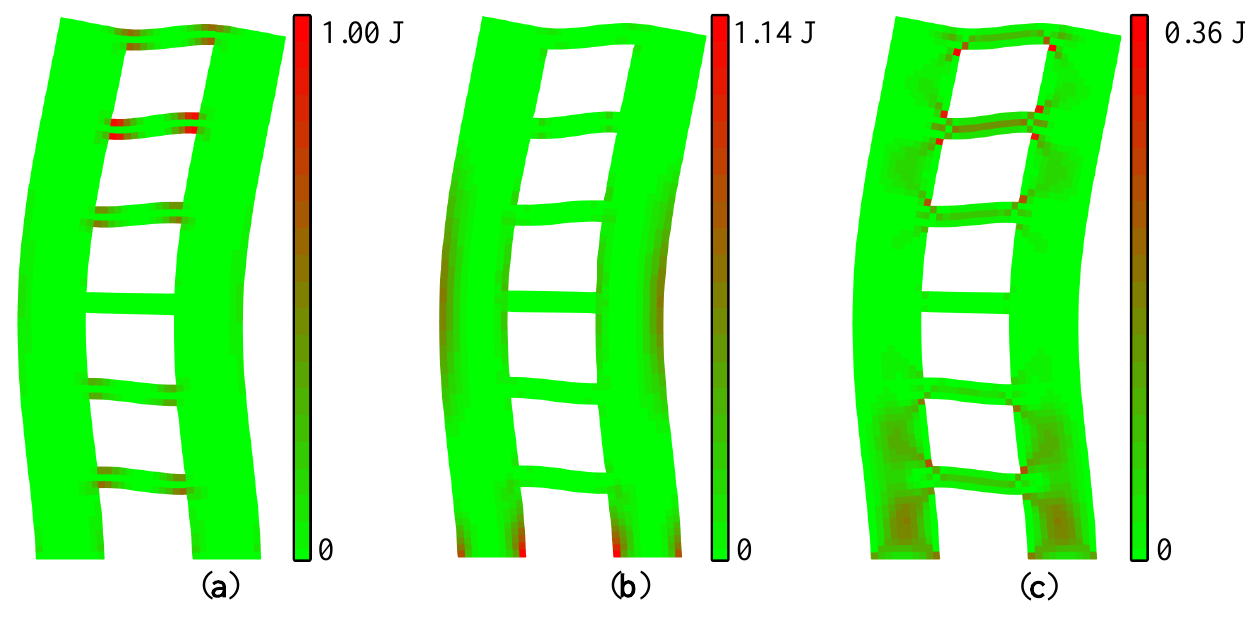
Figure 13. Modal strain energy cloud diagram of second-order vibration mode: ( a ) X-direction modal normal strain energy, ( b ) Y-direction modal normal strain energy, and ( c ) modal shear strain energy. The relatively weak areas of shear wall B under the first two modes are shown in Table 4. Table 4. Relatively weak areas of shear wall B under the first- and second-order vibration